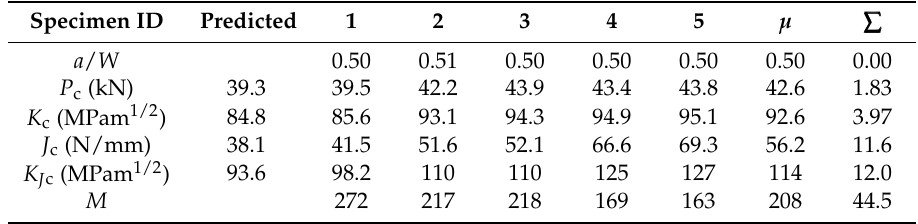
Table 7. Fracture toughness test results for case with CRS (S45C, SE(B) specimen, W = 46 mm, B / W = 0.5, − 10 ◦ C). Here, µ and ∑ denote the mean and standard deviation of each parameter,